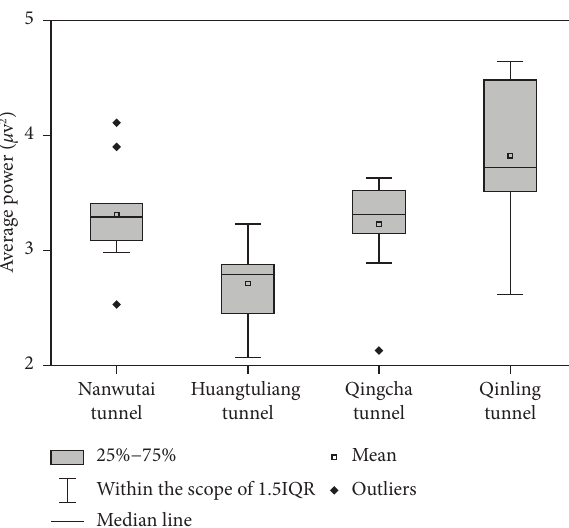
Figure 10: Drivers’ EEG power changing